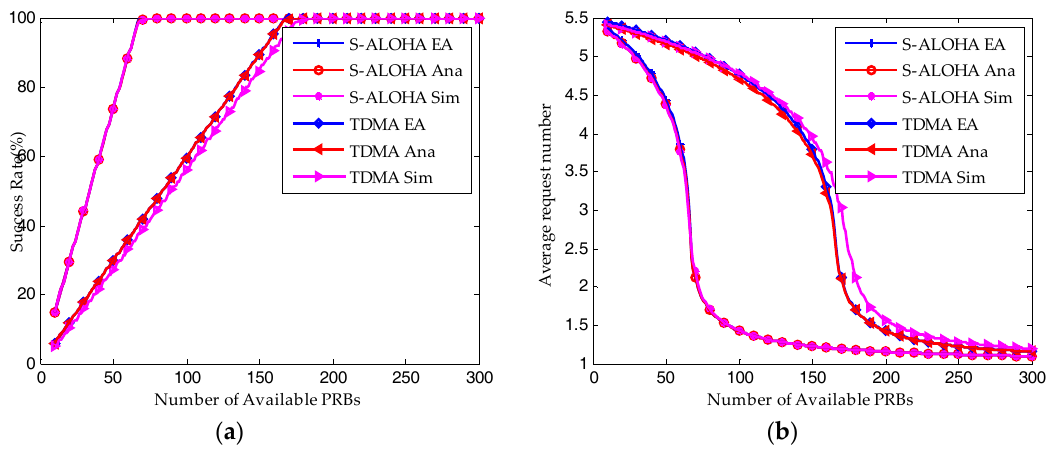
Figure 6. Comparison of simulation results with equilibrium analysis and iterative analytical results ( λ = 50, Q = 10, W BO = 0): ( a ) Average success probability; ( b ) Average request number.